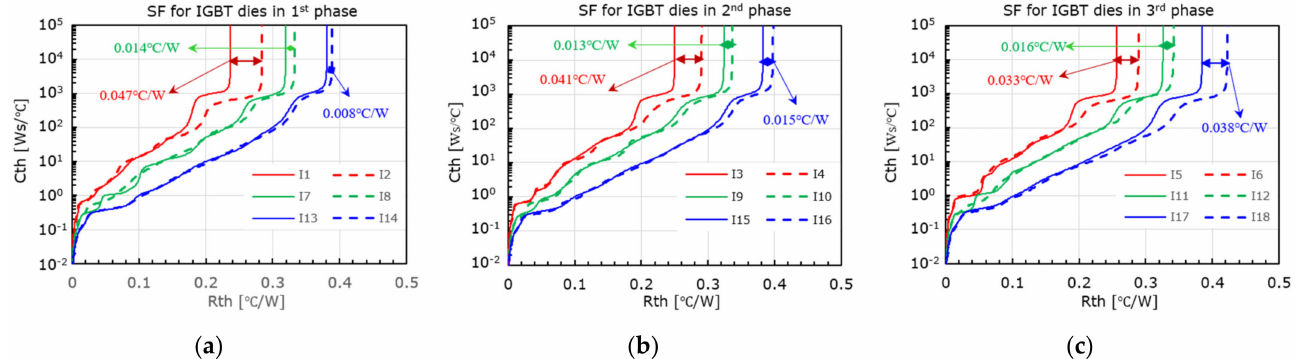
Figure 4. Structure functions (SFs) of heat-flow paths for the measured insulated gate bipolar transistor (IGBT) dies under heating current of 100 A: ( a ) 1st phase, ( b ) 2nd phase, ( c ) 3rd phase. The solid and dashed lines represent the SFs of heat-flow path for the power dies of the upper side and lower side, respectively, while the red, green and blue lines are the standards for SFs for GM_2, GM_1, and